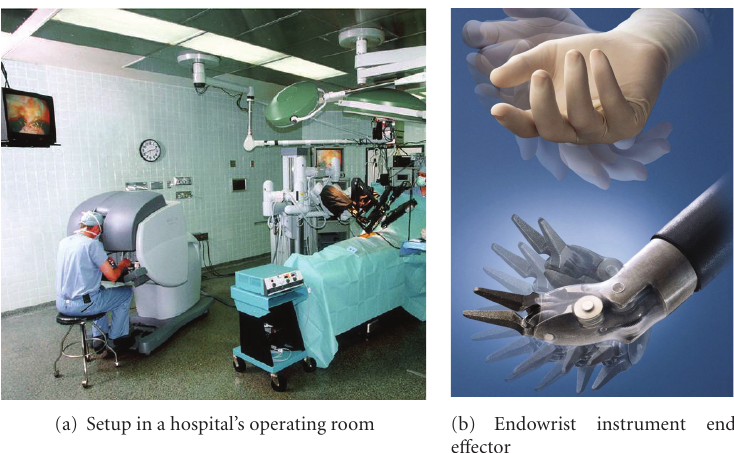
Figure 1: (a) Surgeon operating da Vinci system (by Intuitive Surgical Inc.) for telesurgery. (b) Endowrist is a feature of the robotic system, with multi-DOF at its end e ff ectors. The robotic system provides high dexterity, hand-tremor cancellation, and three-dimensional views for the endoscopic surgery